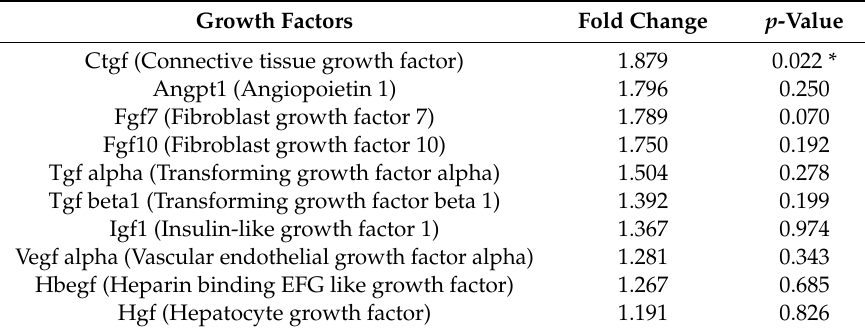
Table 1. List of G75-altered growth factor genes in excisional mouse model.